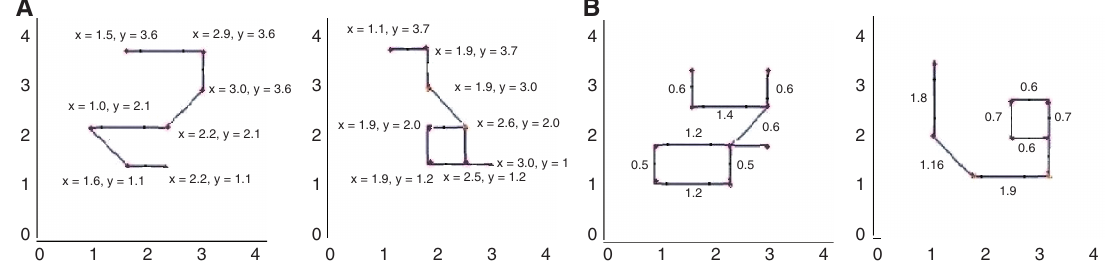
Figure 5: Illustration of Assigning Weights to Numeral Graphs: (A) Each Node Labelled with 2D Coordinates; (B) Each Edge in the Numeral Graph Labelled (Weighted) with the Euclidean Distance Between Two Adjacent